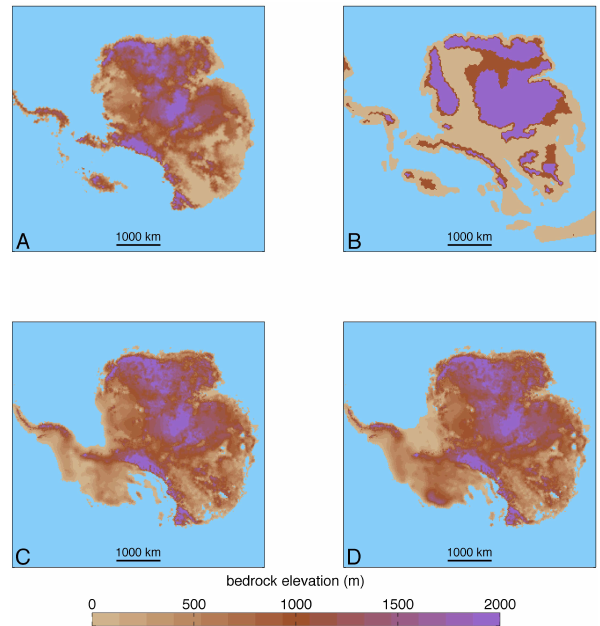
Fig. 1. (a) Isostatically relaxed Bedmap1 topography of Lythe and Vaughan (2001), rotated into early Eocene position (TOPO1). (b) A reduced-resolution version of the proprietary topography used by Lunt et al. (2010); we use a higher-resolution version for our ISM simulations than that shown here (TOPO2). (c) Minimum (TOPO3) and (d) maximum extent reconstructed Eocene/Oligocene topogra- phy of Wilson et al. (2012). Note the increase in land surface area above present-day sea level, in particular for the West